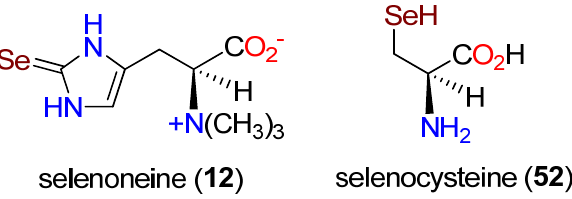
Figure 15. Proposed alternative mechanistic pathways a and b for the interaction of hercynine ( 13 ) and polysulfur in the presence of EanB to form ergothioneine ( 10 ) (adapted from ref. [162]).